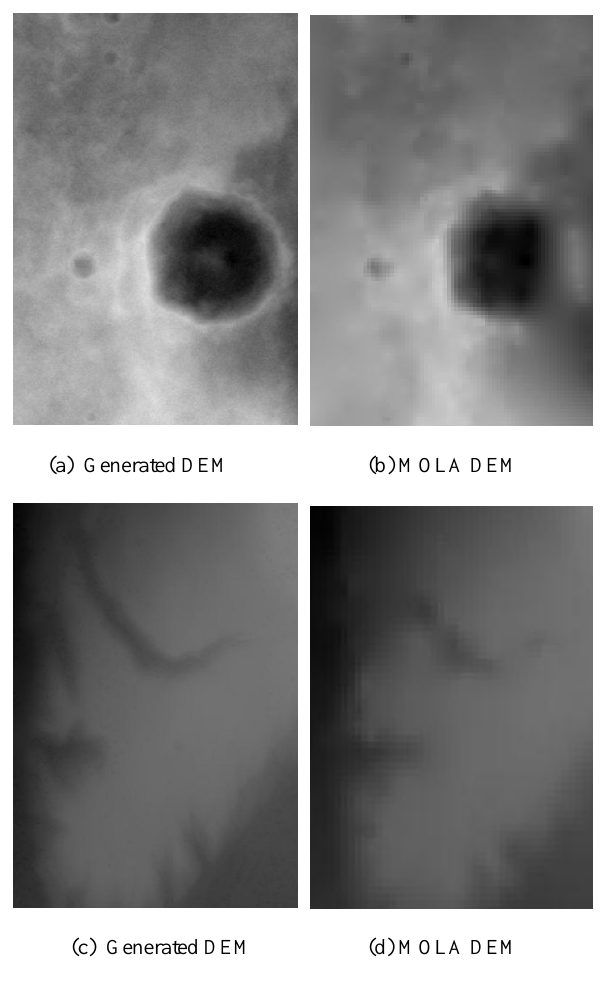
Figure 13. Visual comparison of generated DEM and MOLA DEM. (Height = intensity)